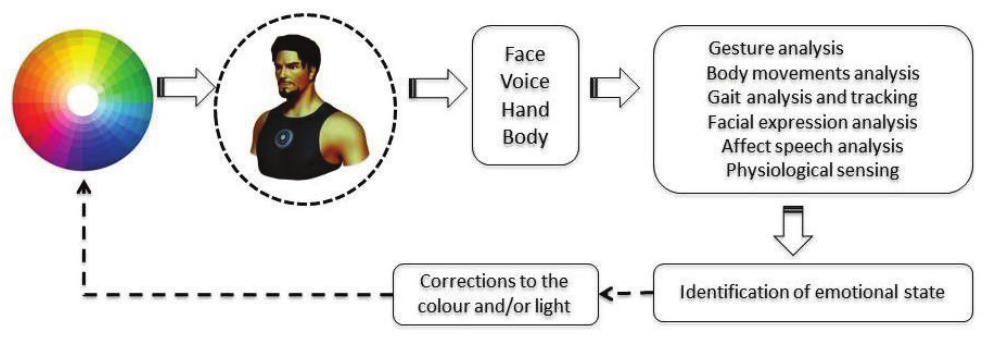
Figure 5. Metamodel for affective modulation through